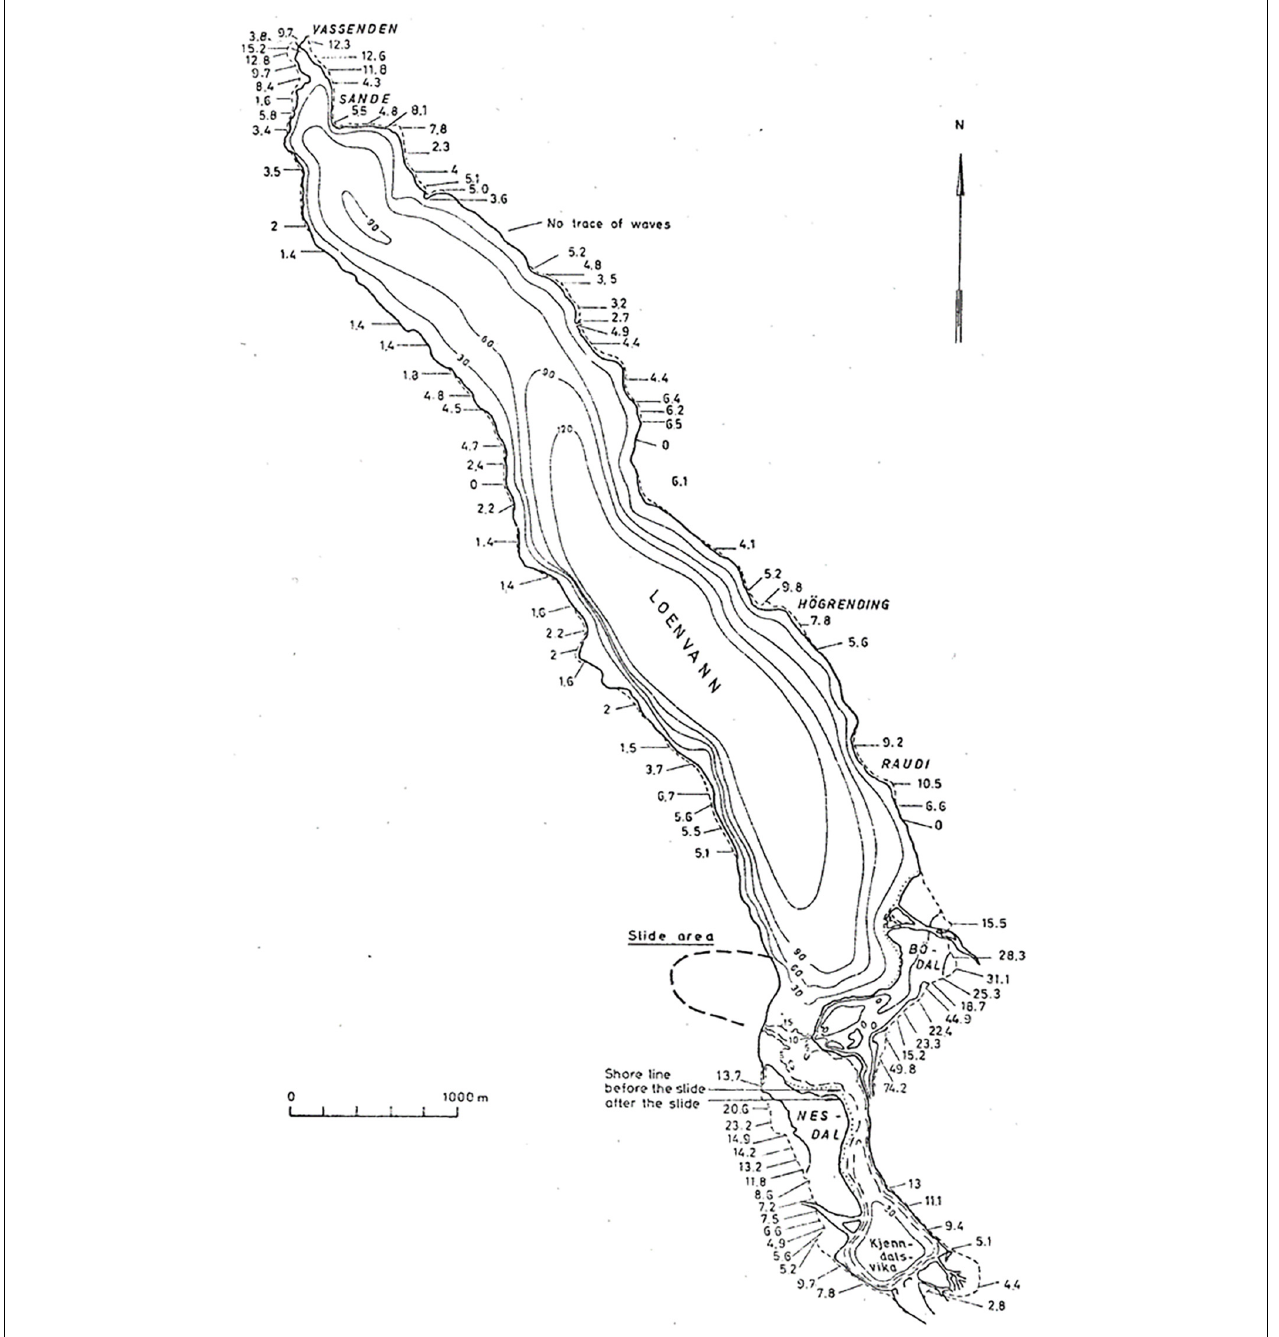
FIGURE 3 | Historical map of Lake Lovatnet with the run-up information measured at high precision following the 1936 tsunami event. Map modified and adapted from Jørstad